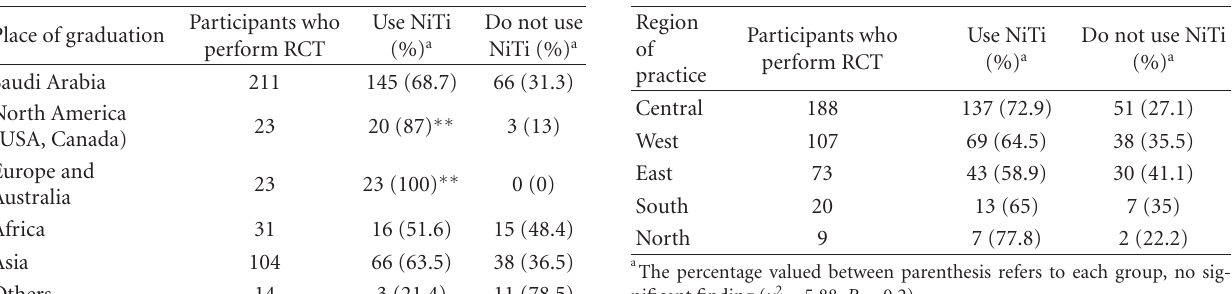
Table 7: Response details for NTRF usage according to region.